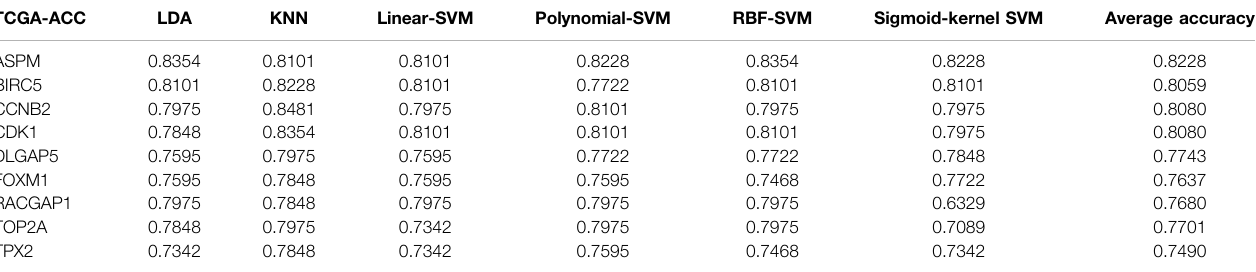
TABLE 2 | The accuracy of classi fi cation of LDA-based classi fi er, KNN-based classi fi er, linear-SVM-based classi fi er, polynomial-SVM-based classi fi er, RBF-SVM-based classi fi er, and sigmoid-kernel-SVM based classi fi er. TCGA-ACC